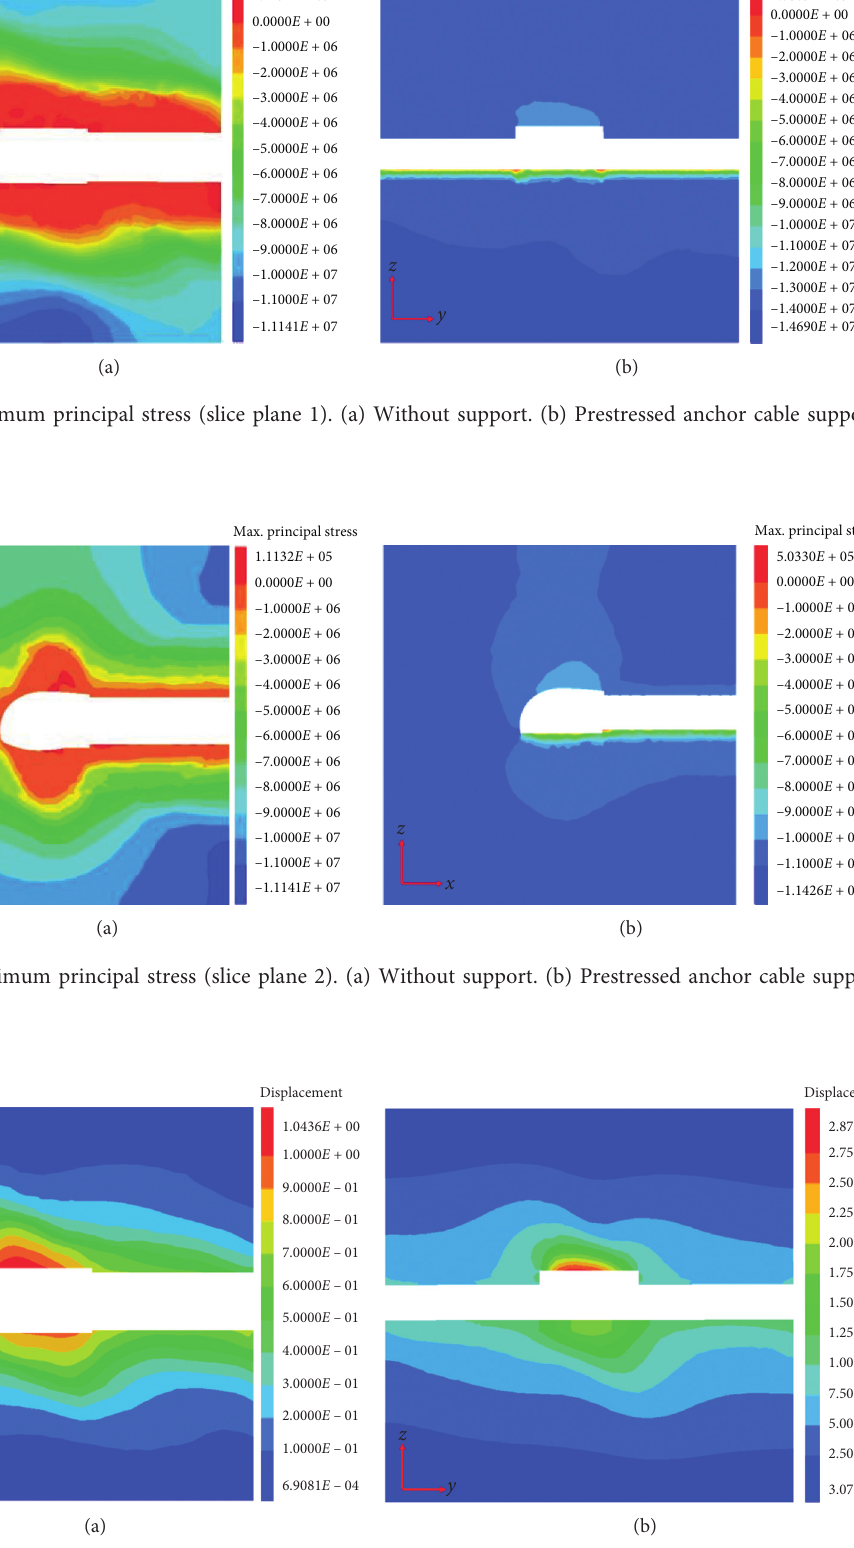
Figure 11: Displacement of surrounding rock (slice plane 1). (a) Without support. (b) Prestressed anchor cable